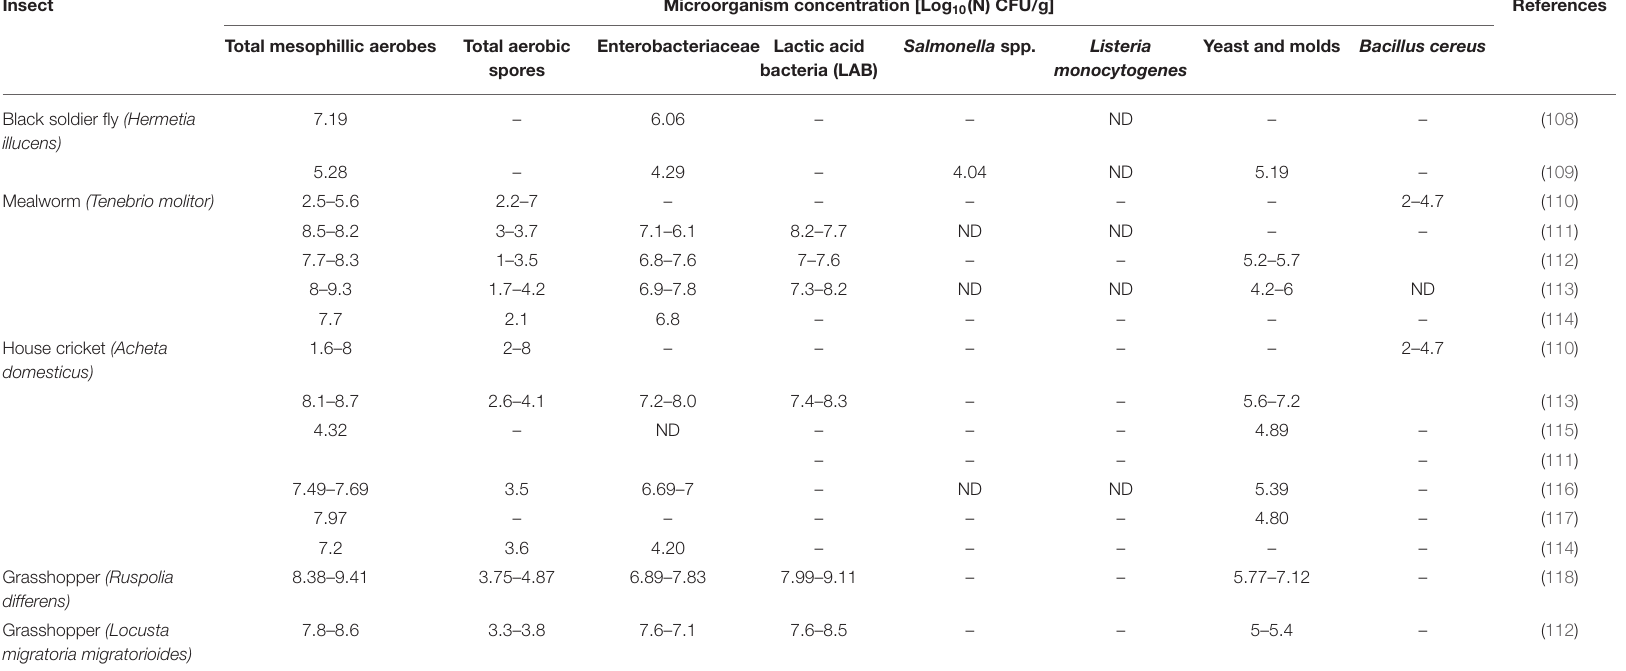
TABLE 4 | Microbial contamination [Log 10 (N) (CFU/g)] reported for different